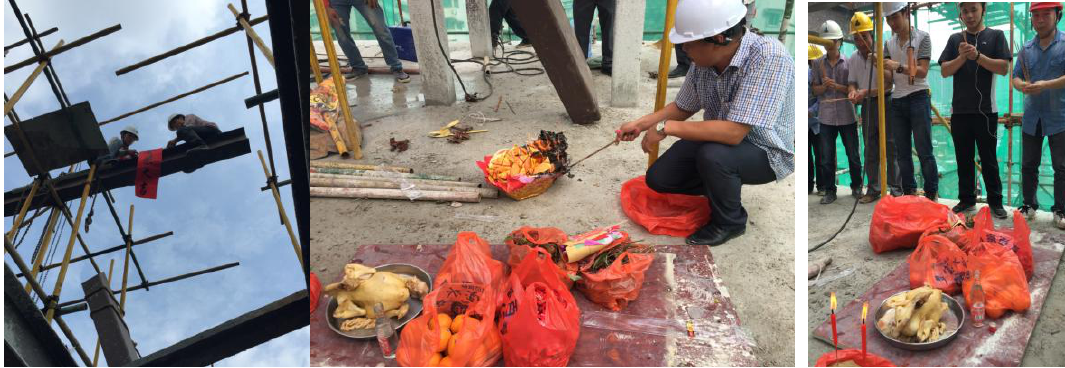
Fig. 9 Traditional roof-beam （ ShangLiang ） ceremony held at the Cantonese Opera Art